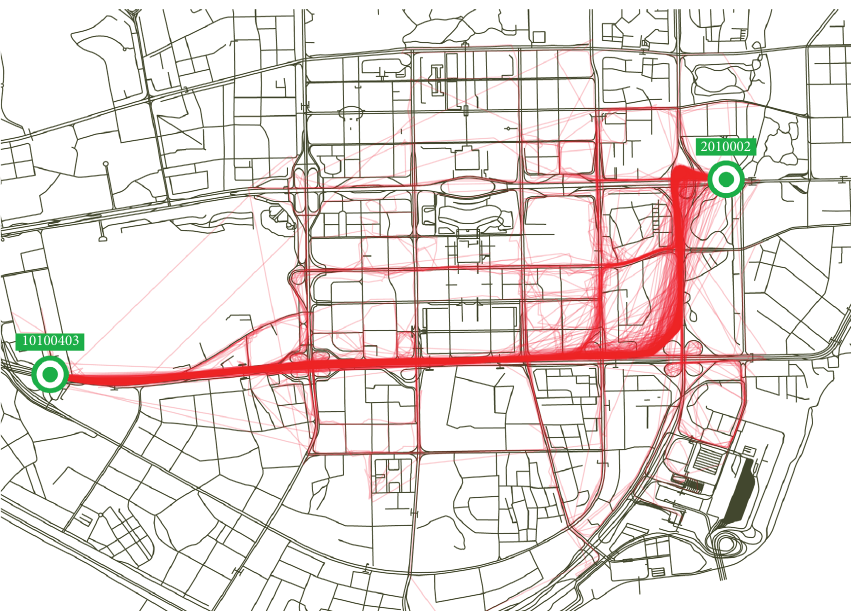
Figure 9: GPS trajectories between the example sensor pair: ( F